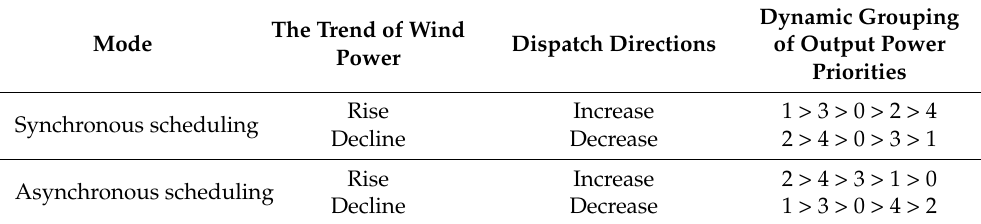
Table 5. Wind power output priorities.